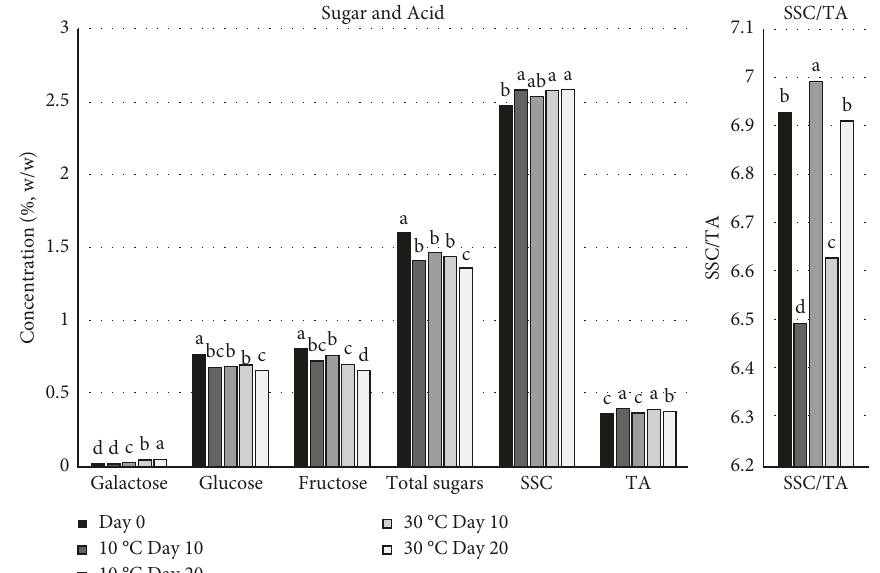
Figure 1: Sugar and acid concentration (%, w/w), and SSC/TA in winter melon juices stored under different conditions. (SSC: soluble solids content; TA: titratable acidity; mean values followed by different letters in the same column indicate significant differences using t -test ( p < 0 .